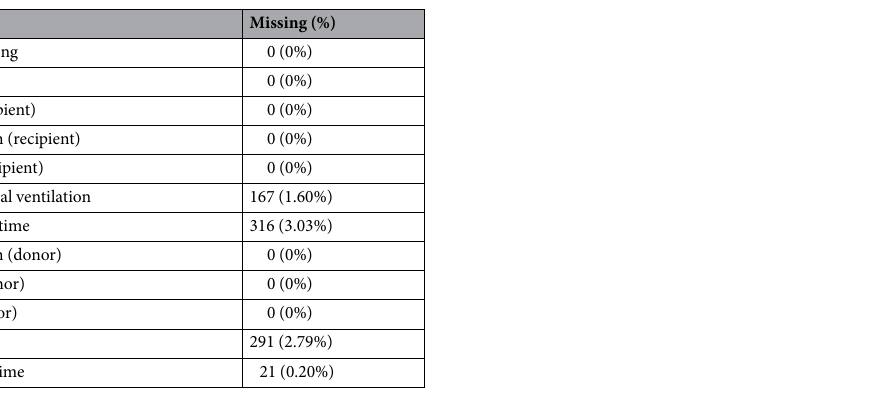
Table 4. Missing data in dataset from who undergone lung transplant for COPD, IPF and sarcoidosis in the US in from December 2005 through December